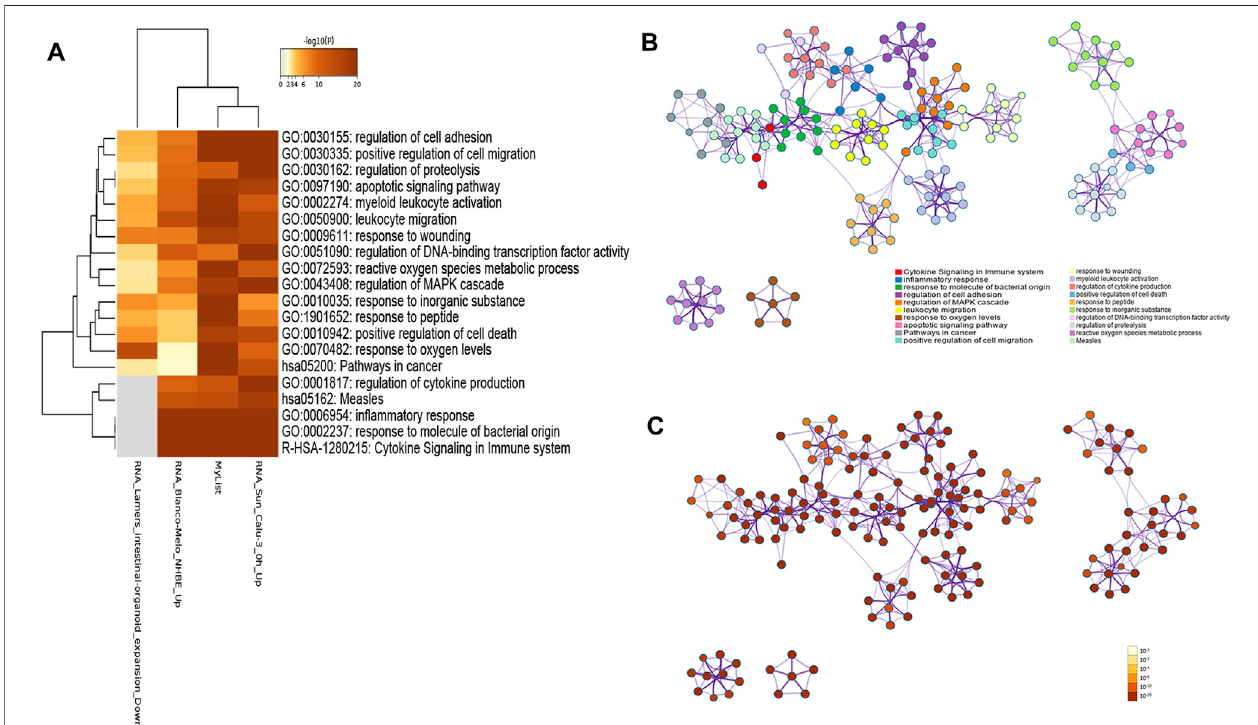
FIGURE 4 | (A) Heatmap of the top 20 enriched GO terms for 192 genes by Metascape, colored by p -values. The darker the color, the higher the ranking. (B) Network of enriched terms colored by cluster ID, where nodes that share the same cluster ID are typically close to each other. (C) Network ofenriched terms colored by p -value, where terms containing more genes tend to have a more signi fi cant p